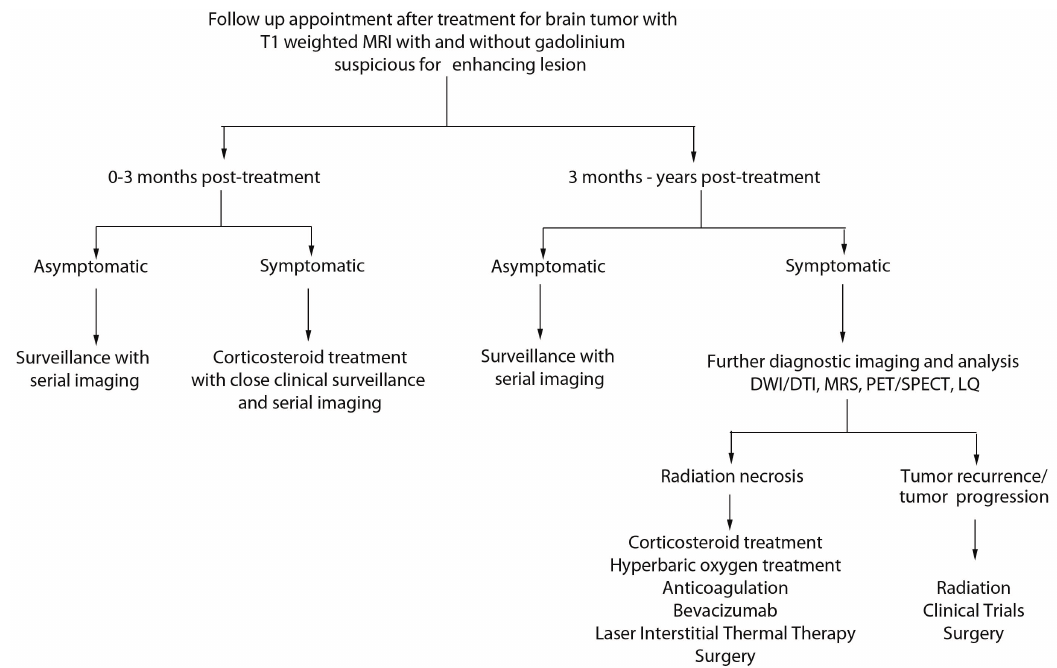
Figure 1. An algorithm to aid in the diagnosis and management of patients with pseudoprogression, radiation necrosis and tumor